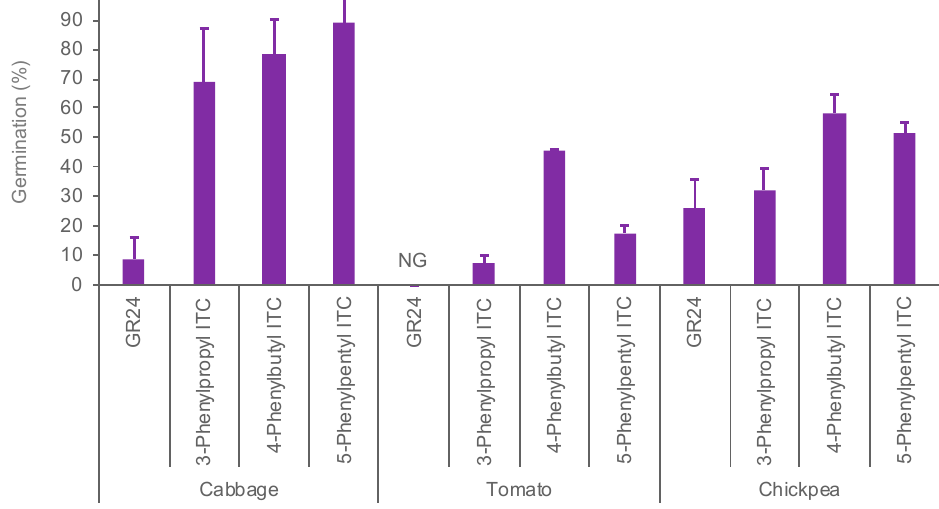
Figure 5. Effects of GR24 and ITCs on germination of P. aegyptiaca parasitizing different host plants including cabbage, tomato, and chickpea. Stimulant activities were examined at 10 − 9 M. NG means no germination. Bar means standard errors ( n = 6).